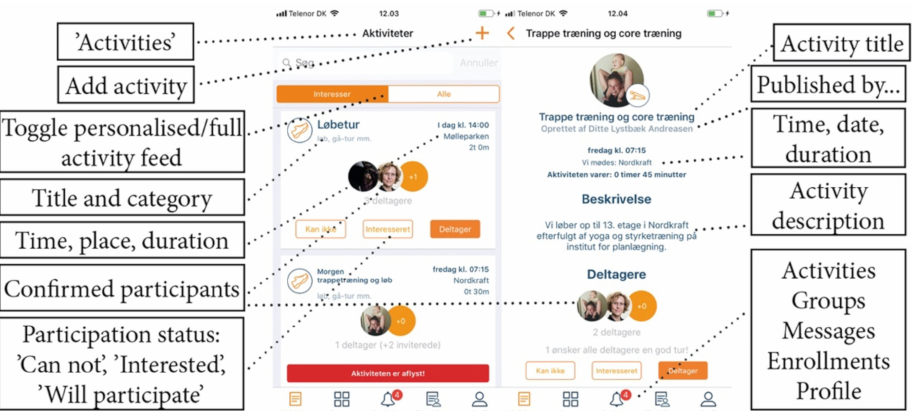
Figure 1. The design of the mobile application. To the left, the entry screen where users can browse through activities in their residential areas (i.e., the healthy horizon). On the right, details and opportunities to join activities (i.e., the ‘healthy